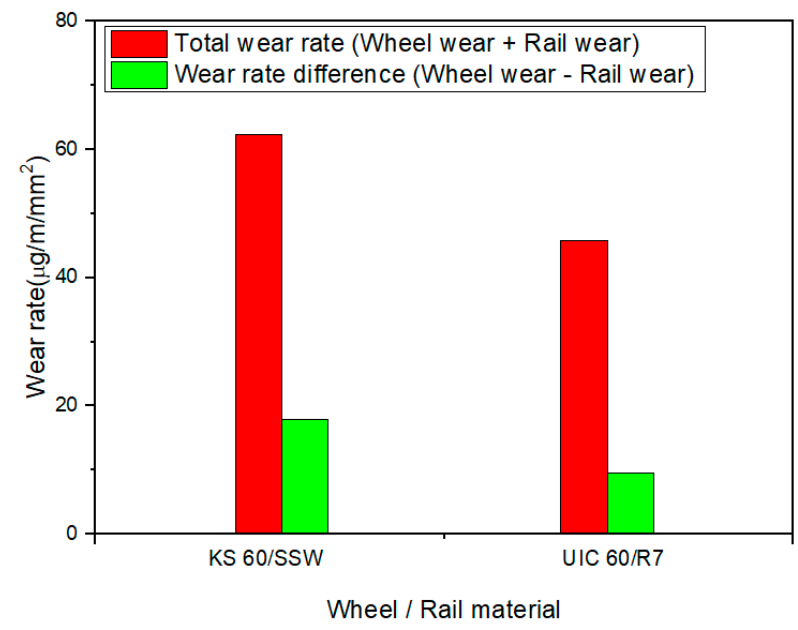
Figure 17. Total wear rate and difference. The mechanical property of materials most influential on wear is the surface